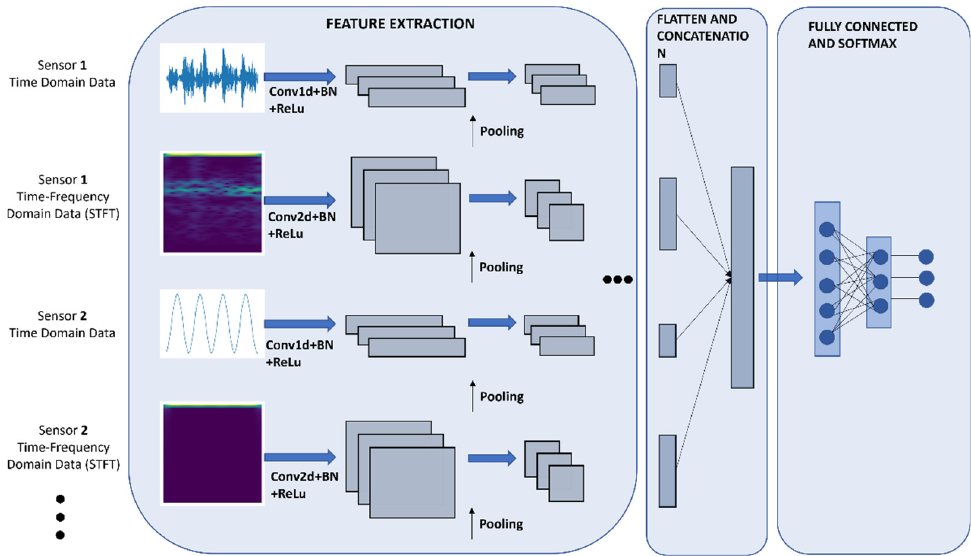
Figure 1. The proposed DL model